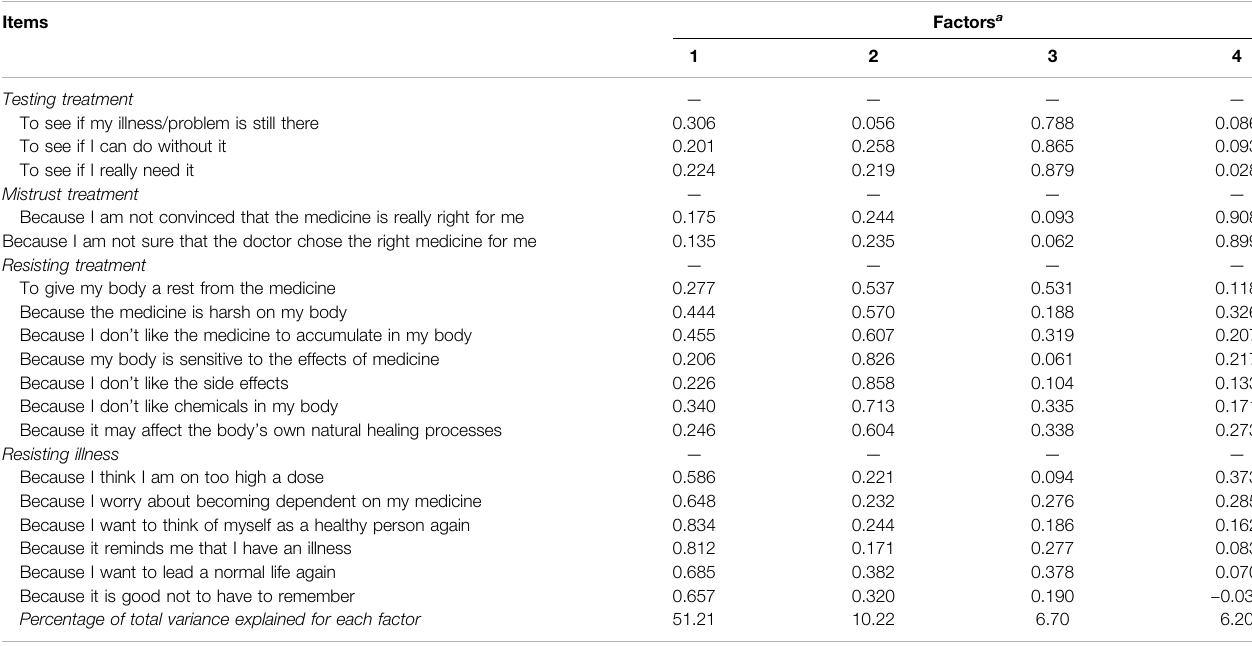
TABLE 2 | Exploratory factor Analysis structure of the INAS: loading for each factor and each item in the model with four factors after an orthogonal varimax rotation and factor extraction using principal components ( n (cid:1) 133). Items